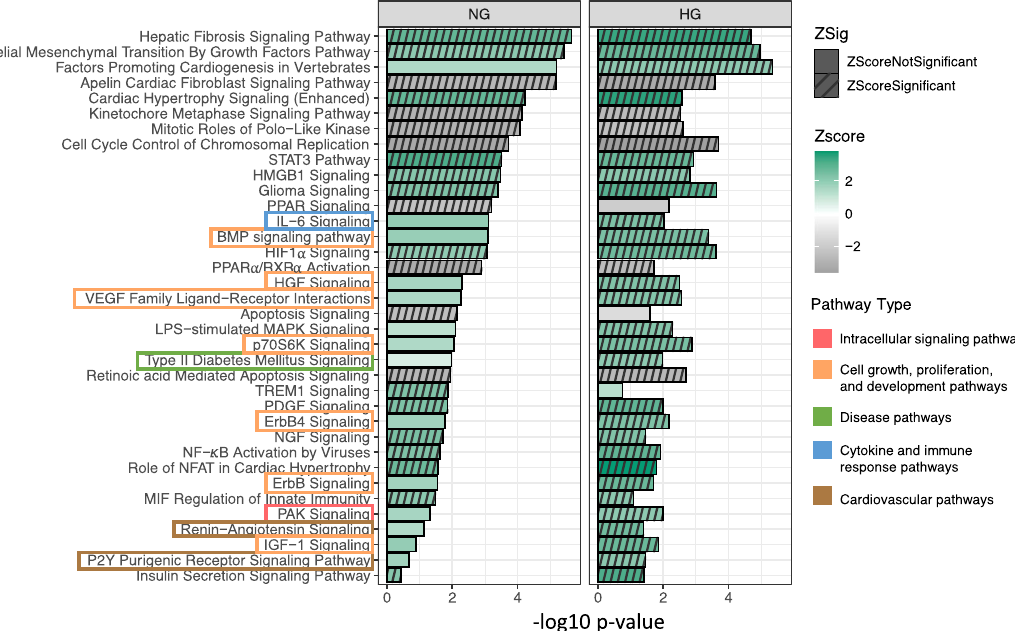
Figure 4. Differential pathway activation/inhibition in HG compared to NG conditions. ( A ) Key pathways highlighted from pathway enrichment analysis of the DEGs (± 1.2 fold change, adjusted p-value < 0.05 for significance) determined at each of the pairwise comparisons of each time point, 0 h vs 0.5 h NG/HG, 0 h vs 1 h NG/HG, 0 h vs 4 h NG/HG, 0 h vs 8 h NG/HG, and 0 h vs 24 h NG/HG using IPA. Dots show non-significant enrichment. ( B ) The 0 vs 4 h pairwise comparison, where most significant pathways are activated/inhibited. A right-tailed Fisher’s Exact test was used to measure significance of the pathway enrichment in the gene set. The horizontal bars show the level of significance (−log10 p-value). The colour coding of bars indicates activation/ inhibition determined by the z-score (generated using fold change and curated pathway relationships from the Ingenuity Knowledge Base), > or < 2 respectively. Hashed bars show significant z-scores. Signalling pathways of interest are highlighted by colour coded